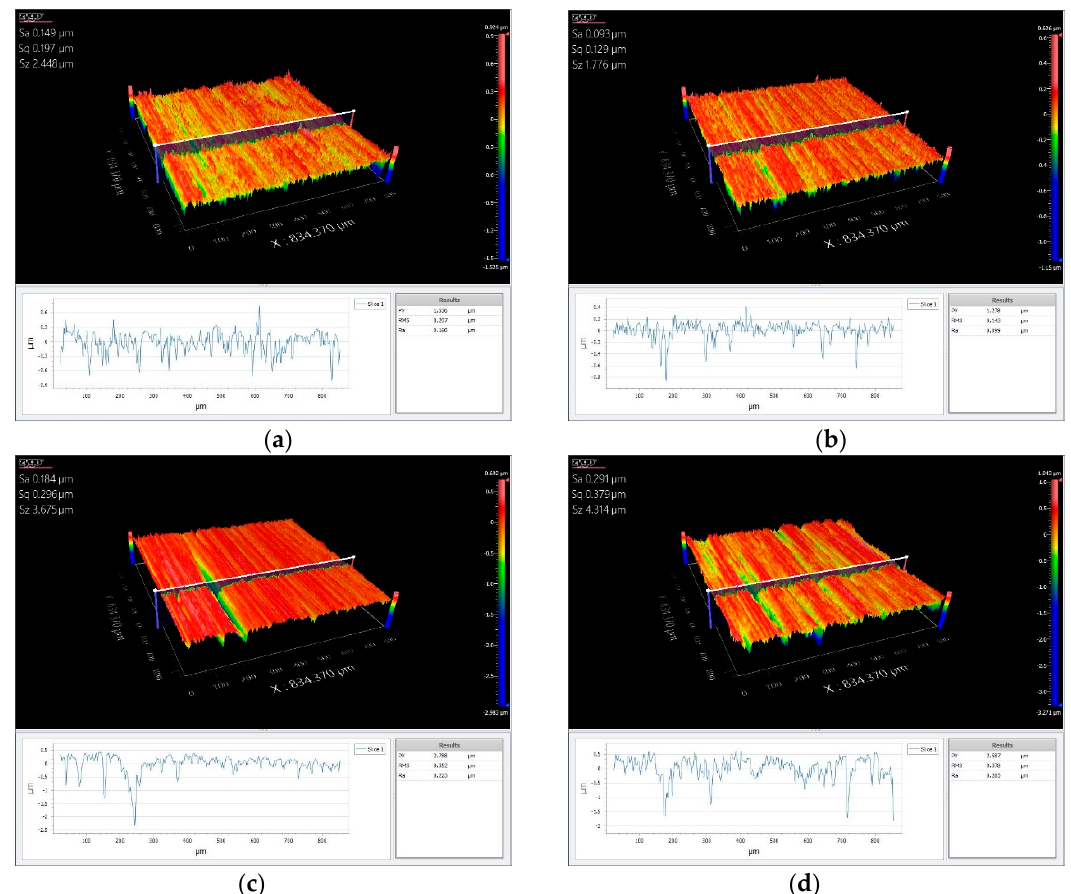
Figure 15. Three-dimensional (3D) surface images of the bearing inner ring: ( a ) radial load: 400 N; inner ring speed: 1200 r/min; kinematic viscosity: 15 cSt; ( b ) radial load: 400 N; inner ring speed: 1800 r/min; kinematic viscosity: 15 cSt; ( c ) radial load: 600 N; inner ring speed: 1800 r/min; kinematic viscosity: 32 cSt; and ( d ) radial load: 600 N; inner ring speed: 1200 r/min; kinematic viscosity: 46 cSt.